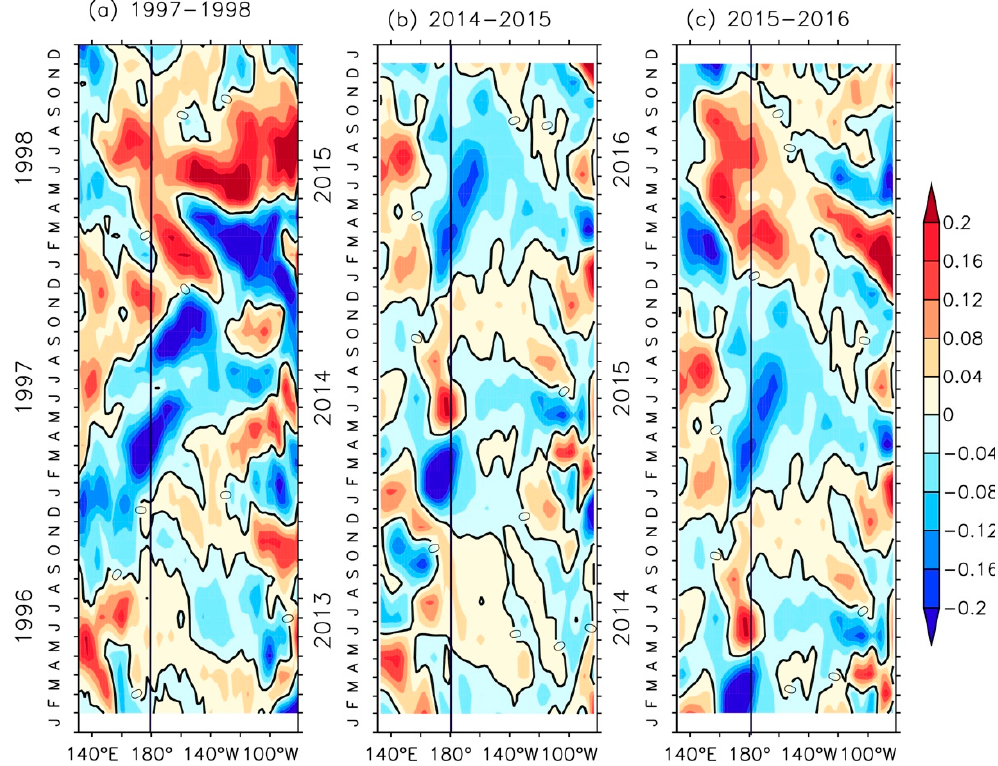
Figure 6. Longitude–time sections of mixed layer salinity (MLS) tendency along the equator (averaging over 2° S–2 ° N) during ENs for ( a ) 1997–1998, ( b ) 2014–2015, and ( c ) 2015–2016. The vertical black line represents the location of the international the dateline. The units for MLS tendency are psu/month.